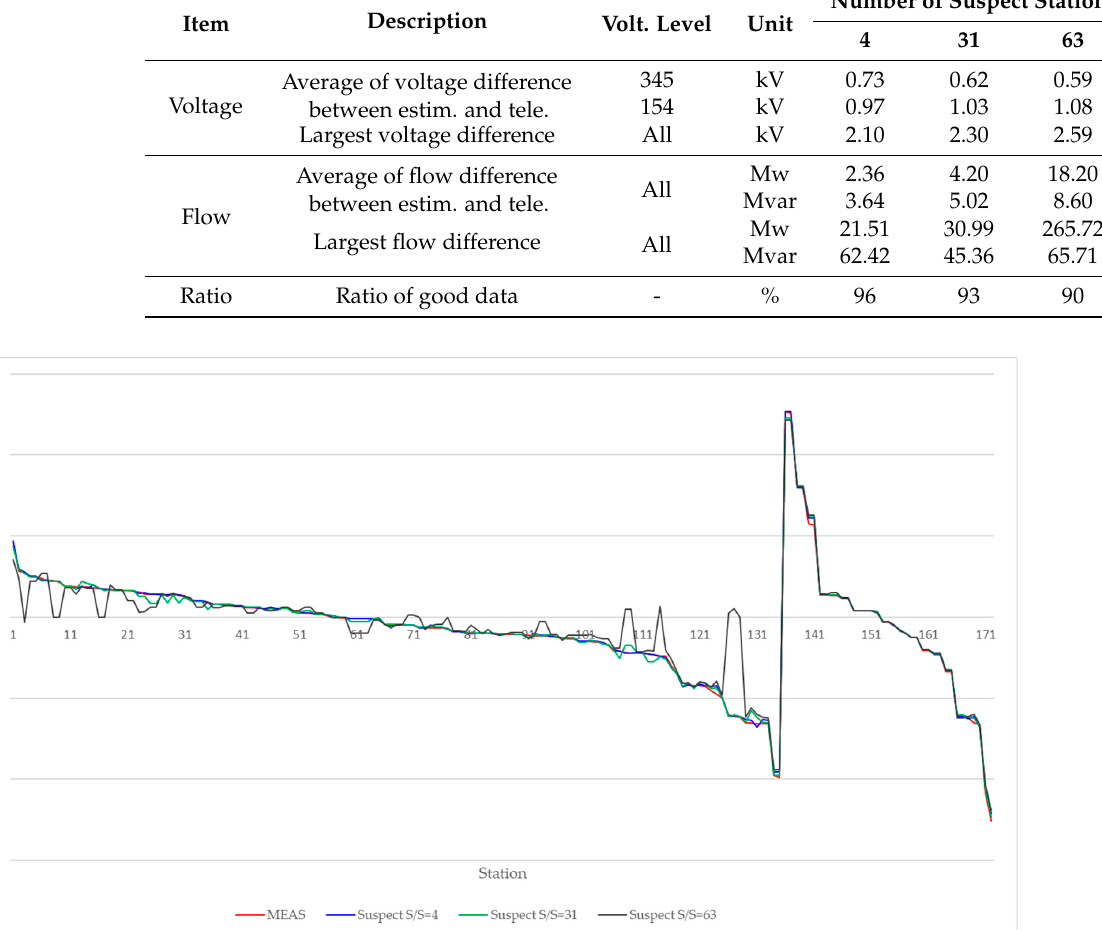
Figure 16. Estimation results and measurements for the branch flow in the Nam-Seoul division.